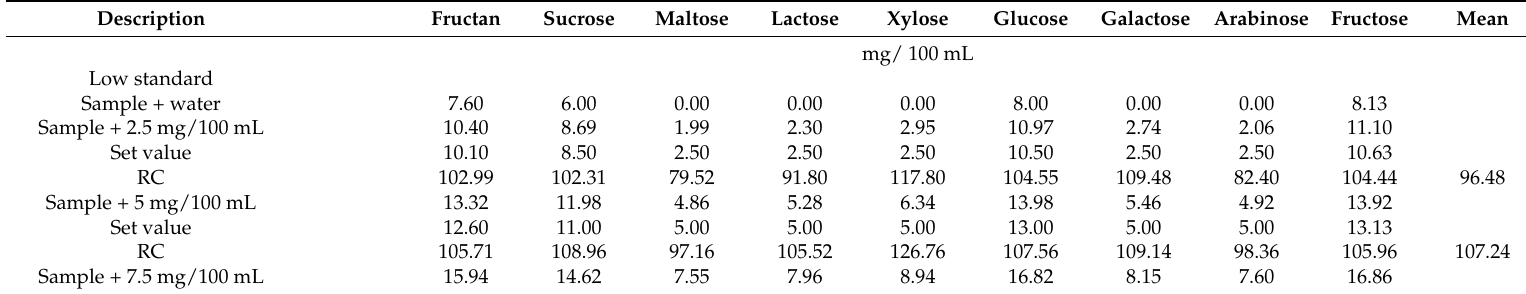
Table 7. Recovery (RC,%) in an aqueous grass silage extract supplemented with calibrated model solution ( n = 1) at low standard level (5 to 30 mg/100 mL) and high standard level (15 to 300 mg/100